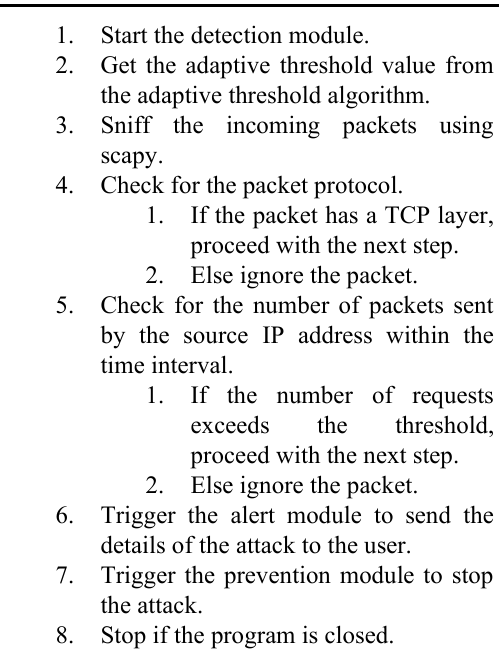
Fig.4 TCP-SYN Flood attack detection